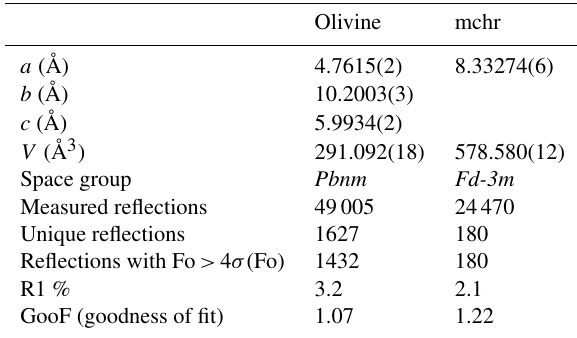
Table 1. Unit-cell parameters, data collection information and re- finement details for the touching olivine and mchr inclusion in the studied diamond. Note the remarkable agreement factors of the de- termined crystal structures of both the olivine (R1% = 3.2%) and mchr (R1% = 2.1%)